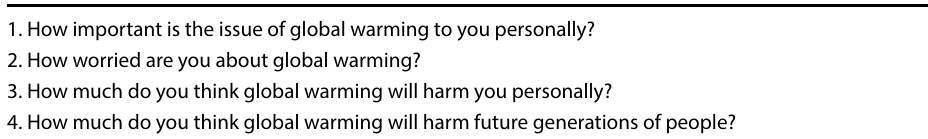
Table 2 Yale’s Six Americas Super Short Survey